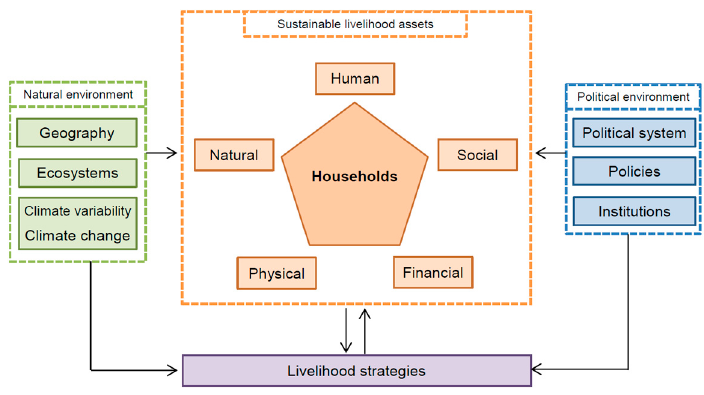
Figure 1. Sustainable livelihoods framework (adapted from [30]).